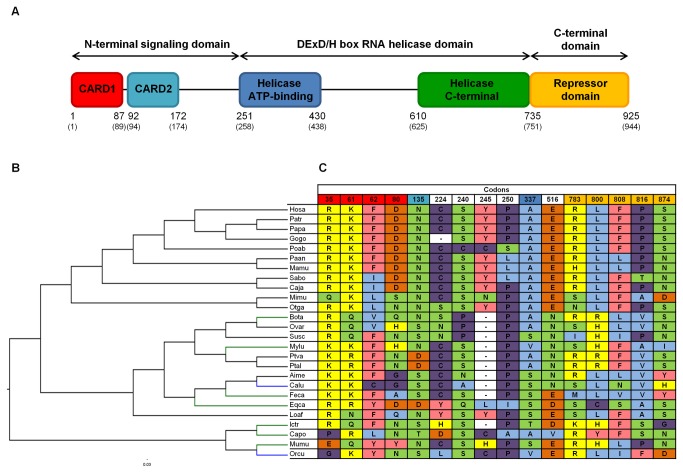
Structural representation and identification of positively-selected branches and codons in mammalian RIG-I.(A) Based on human protein structure, the key domains of RIG-I (http://www.uniprot.org/uniprot/O95786) and the corresponding boundaries are schematically represented. Also, the human domain boundaries while in the mammalian RIG-I deduced protein sequences alignment (Figure S4) are shown in brackets. (B) Cladogram of 26 mammalian RIG-I genes collected from Ensembl and NCBI databases. Branch-site analyses were performed to identify specific branches under episodic positive selection. Branches with statistically significant likelihood ratio tests (LRTs) when performing PAML branch-site model A (Table 2) are colored in green; branches simultaneously identified by PAML branch-site model A and Hyphy branch-site REL method (Table 5) are colored in blue. (C) Positively-selected codons are exhibited in the table and numbered according to the mammalian RIG-I deduced protein sequences alignment (Figure S4). Symbol “-” represents a deletion. Colors on the codon numbering row correspond to the RIG-I domain with the same color in the protein structural representation (A). The background colors on the identified sites match different amino acid properties: polar positive (yellow), polar negative (orange), polar neutral (green), non-polar neutral (purple), non-polar aliphatic (blue) and non-polar aromatic (pink). The used abbreviations correspond, by order of appearance, to the following species: Hosa – Human; Patr – Chimpanzee; Papa – Bonobo; Gogo – Gorilla; Poab – Orangutan; Paan – Olive baboon; Mamu – Rhesus macaque; Sabo – Black-capped squirrel monkey; Caja – Marmoset; Mimu – Mouse lemur; Otga – Bushbaby; Bota – Cow; Ovar – Sheep; Susc – Pig; Mylu – Little brown myotis; Ptva – Large flying fox; Ptal – Black flying fox; Aime – Giant panda; Calu – Dog; Feca – Cat; Eqca – Horse; Loaf – Elephant; Ictr – Squirrel; Capo – Guinea pig; Mumu – Mouse; Orcu – European rabbit.